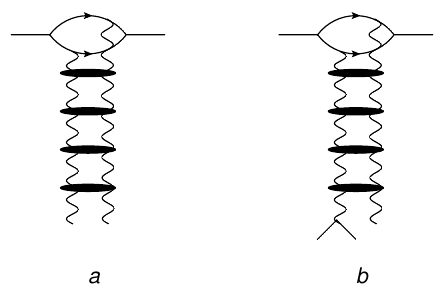
Figure 4 . (a) the amplitudes D 2 and (b) D 3